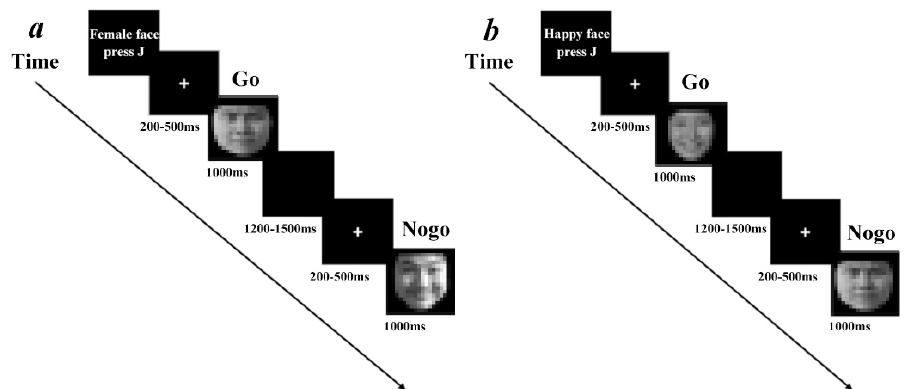
Figure 1. ( a ) Task-unrelated emotional face go/nogo task. ( b ) Task-related emotional face go/nogo task.